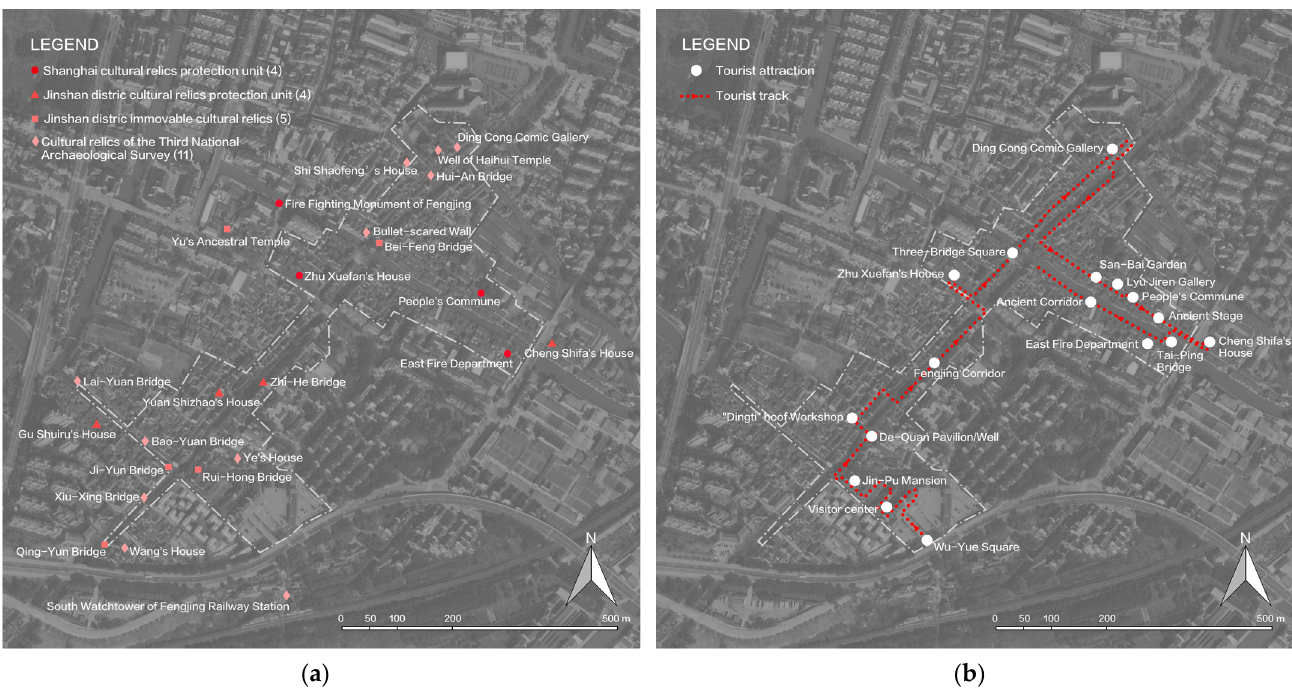
Figure 2. ( a ) The scope of the core protection area and the spatial distribution of cultural relics in Fengjing Ancient Town (source: authors); ( b ) The tourist attractions and tourist routes of Fengjing Ancient Town (source: authors).